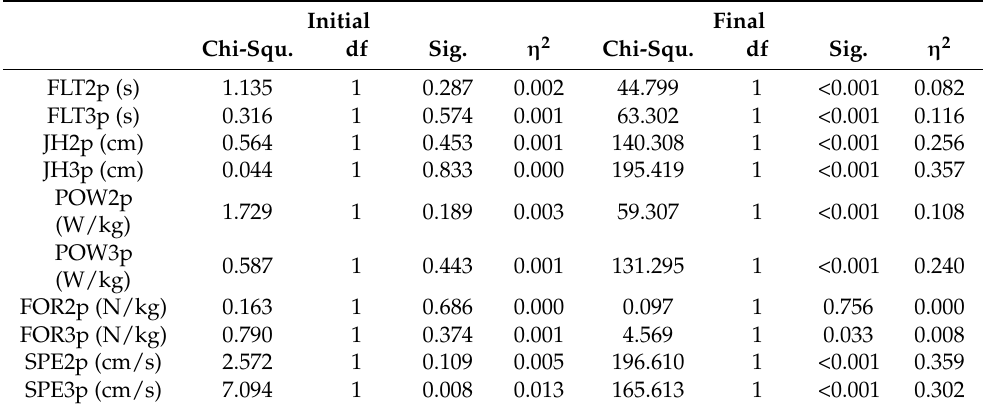
Table 4. Differences between control (C) and experimental (T) group at the initial and final measure- ment calculated by the Kruskall–Wallis test for independent